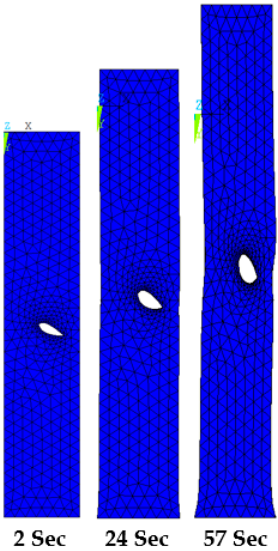
Figure 19. Deformation of the computational model of the skin phantom with wound.